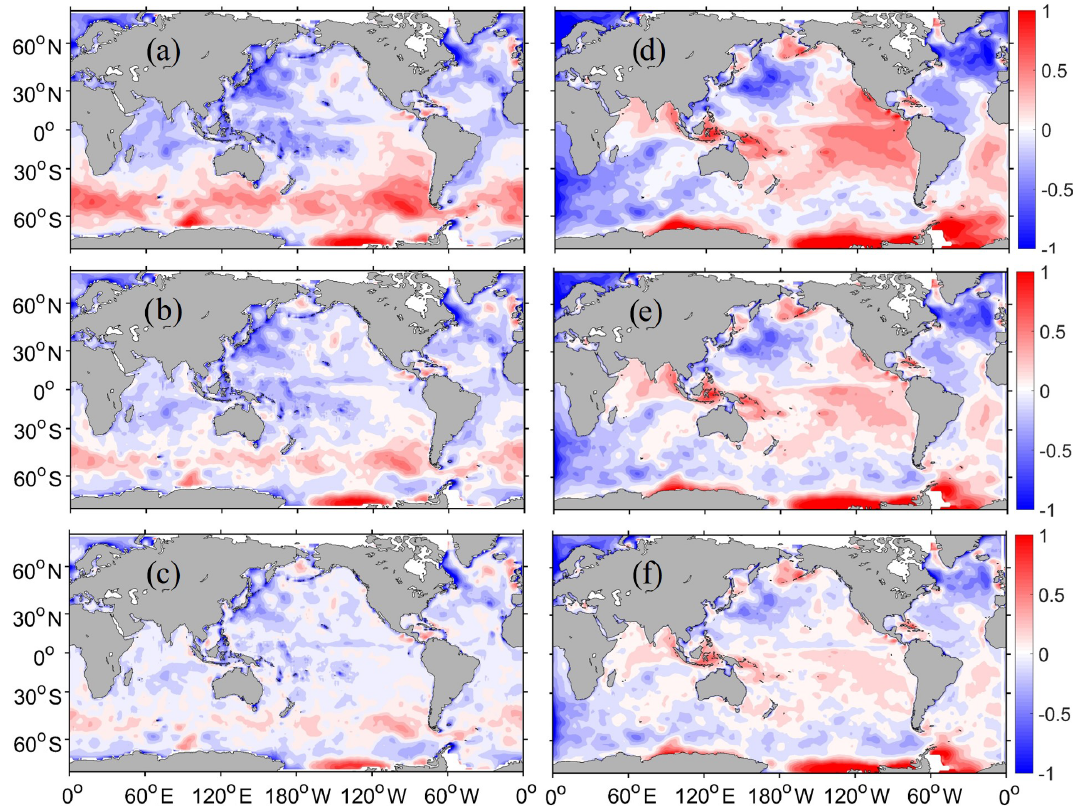
Figure 6. Distributions of SWH mean errors (against the merged grid altimeter data) of the WW3 (a–c) and SWAN (d–f) model simula- tions (a, d) and assimilations with Jason-2 (b, e) , as well as all Jason-2, Jason-3 and SARAL (c, f) data forced by the ERA-Interim wind. The statistics are averaged over the last 30d of a 70d total assimilation period (unit: